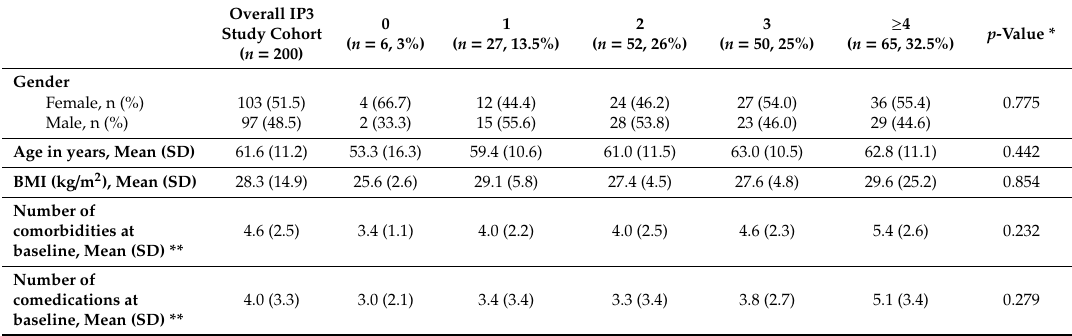
Table 3. IP3 cohort stratified by number of newly initiated drugs with a potential drug-gene interaction within